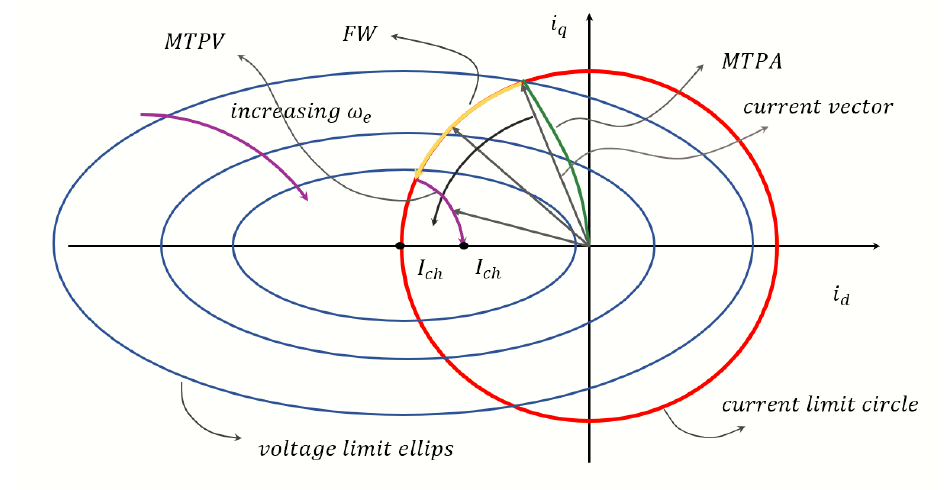
Figure 2. i d − i q plane, MTPA, FW and MTPV control